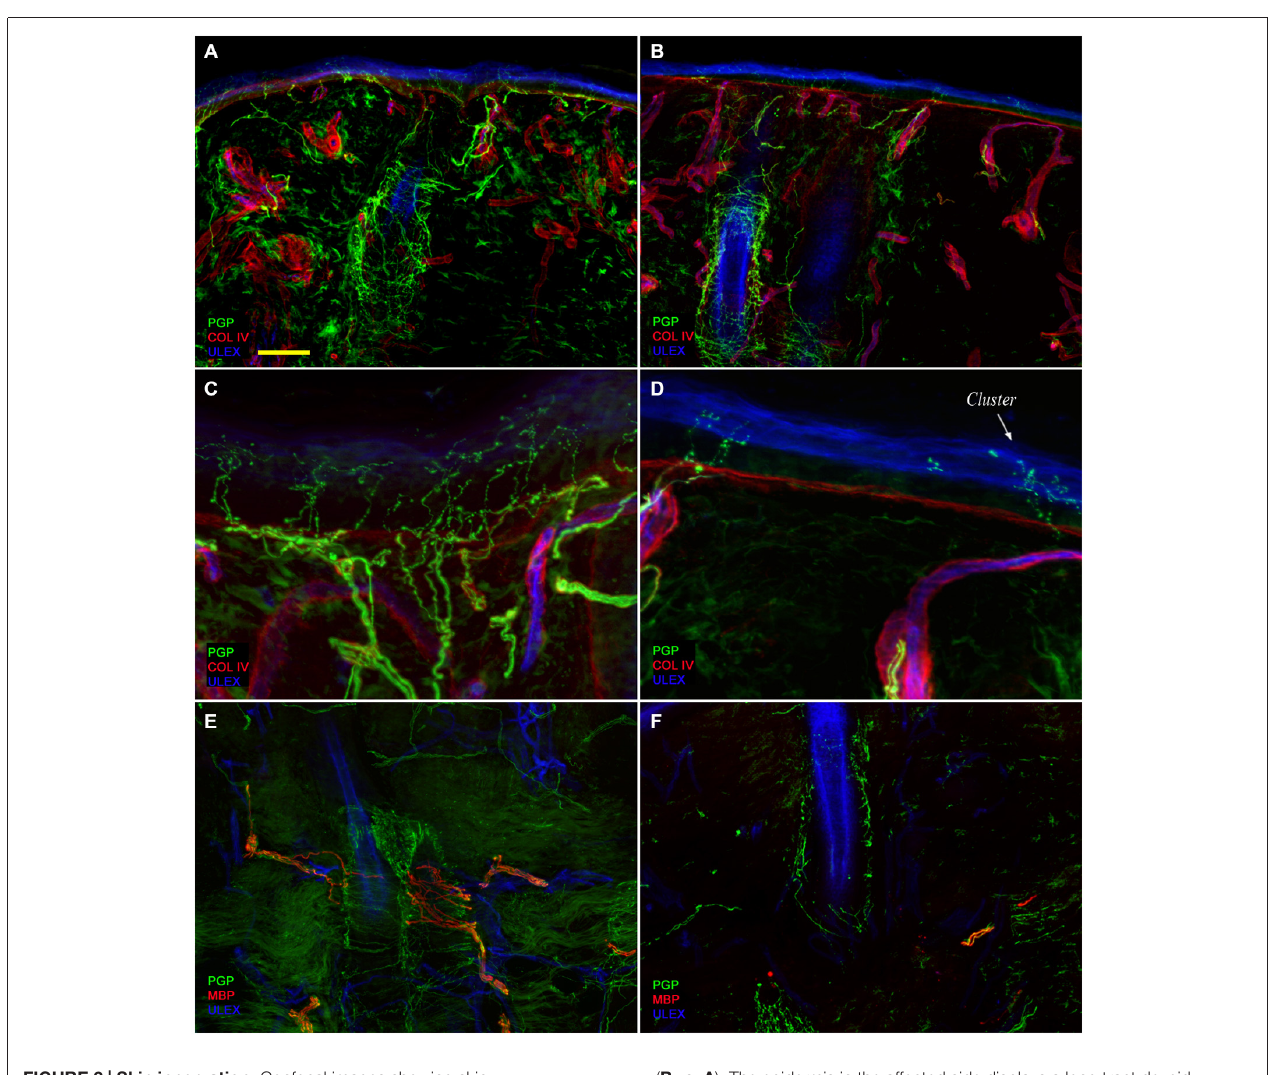
FIGURE 2 | Skin innervation. Confocal images showing skin innervation in the unaffected (A,C,E) and affected side (B,D,F) in a representative patient with PHN. Severe epidermal and dermal nerve fiber loss is visible in skin biopsy specimens from the affected side